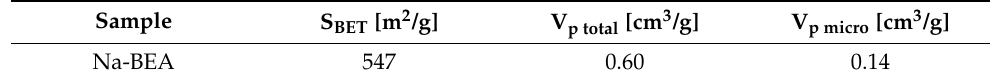
Table 2. BET analysis results for Na-BEA